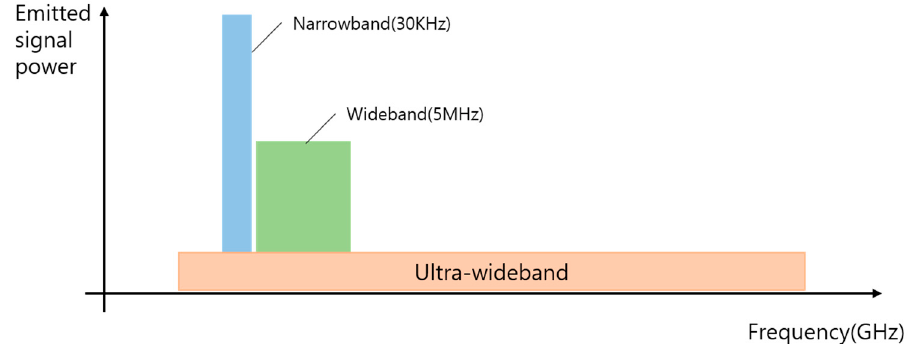
Figure 1. Comparison of the narrowband signal and wideband signal and UWB (Ultra-Wideband) spectrum.